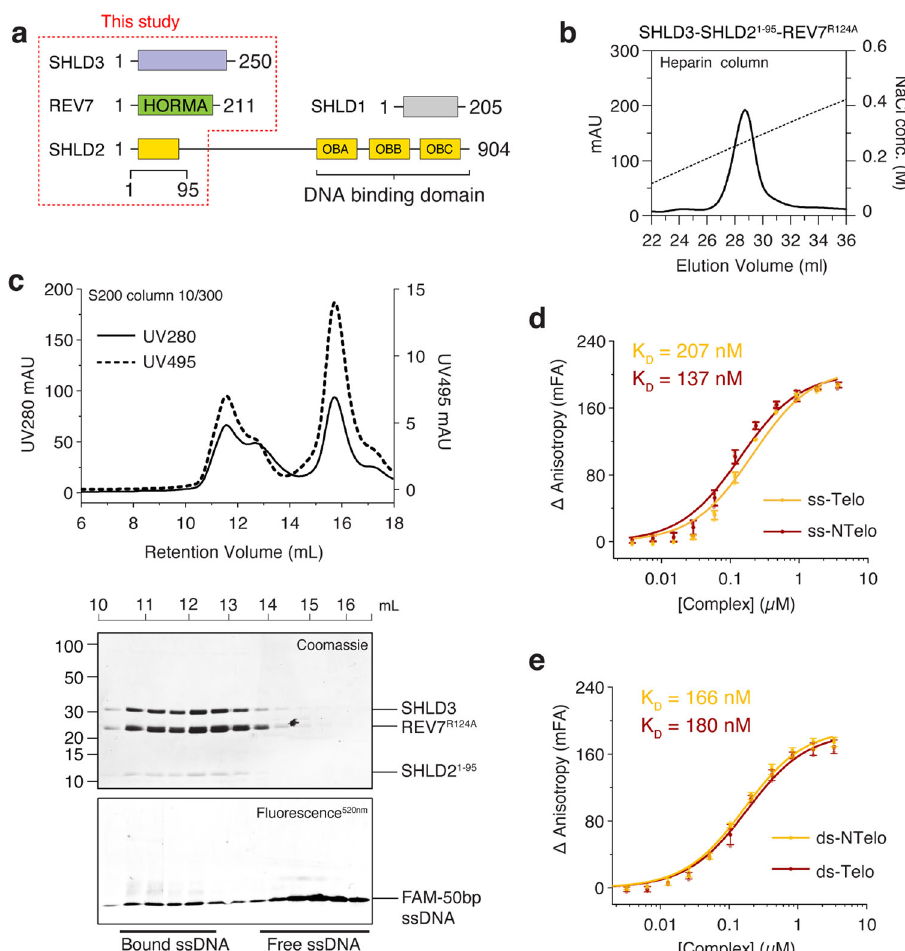
Fig. 1 SHLD3-SHLD2 1 – 95 -REV7 ternary complex binds DNA. a Schematic drawing of the Shieldin complex containing SHLD1, SHLD2, SHLD3 and REV7. Protein constructs present in this study are highlighted. b Heparin column elution pro fi le of the SHLD3-SHLD2 1 – 95 -REV7 complex. Point mutant R124A generates a dimerization-defective REV7 variant. c The SHLD3-SHLD2 1 – 95 -REV7 complex co-migration with ssDNA (Supplementary Tables 1, 2) in size- exclusion chromatography. d , e Fluorescence anisotropy titration experiments of Shieldin complex with ( d ) ssDNA (non-telomeric and telomeric) and ( e ) dsDNA (non-telomeric and telomeric). Error bars represent s.d. ( n = 3 independent experiments). See Supplementary Tables 1, 2 for DNA